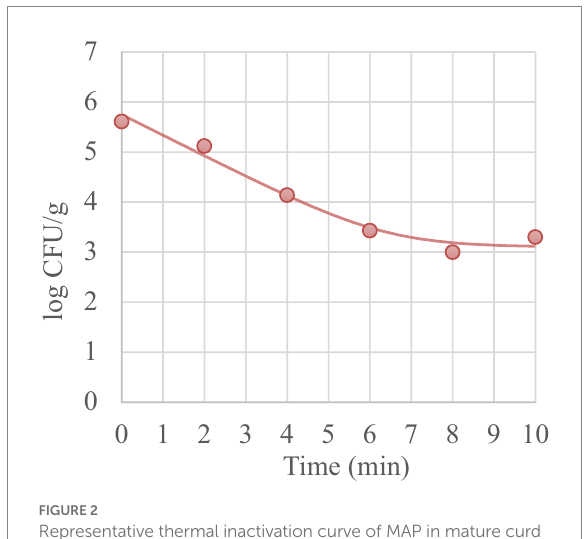
FIGURE 2 Representative thermal inactivation curve of MAP in mature curd treated at 64 ° C. Symbols are the plate count of MAP. Line is the curve generated from the “log-linear +Tail” model (Geeraerd et al.,